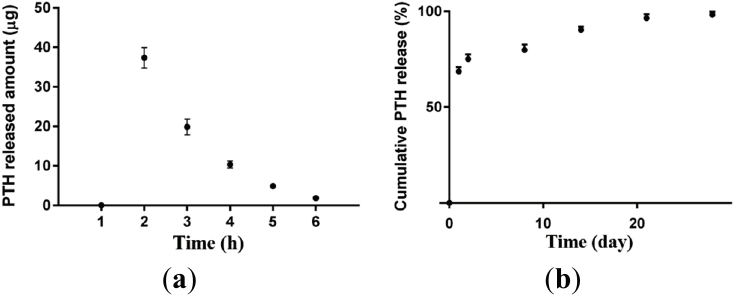
Figure 3. Cumulative PTH release from PLGA nanoparticles ( a ) over the initial 6 h; and ( b ) over 28 days.